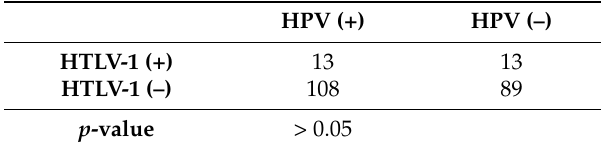
Figure 2. Association of HTLV-1 and human papillomavirus (HPV) type 53 infections. HPV type 53 showed a statistically significant association with HTLV-1 infection (p <0.05). None of the other HPV sub ‐ types showed a positive association. Table 2. Analysis of the association between HTLV-1 and HPV infections